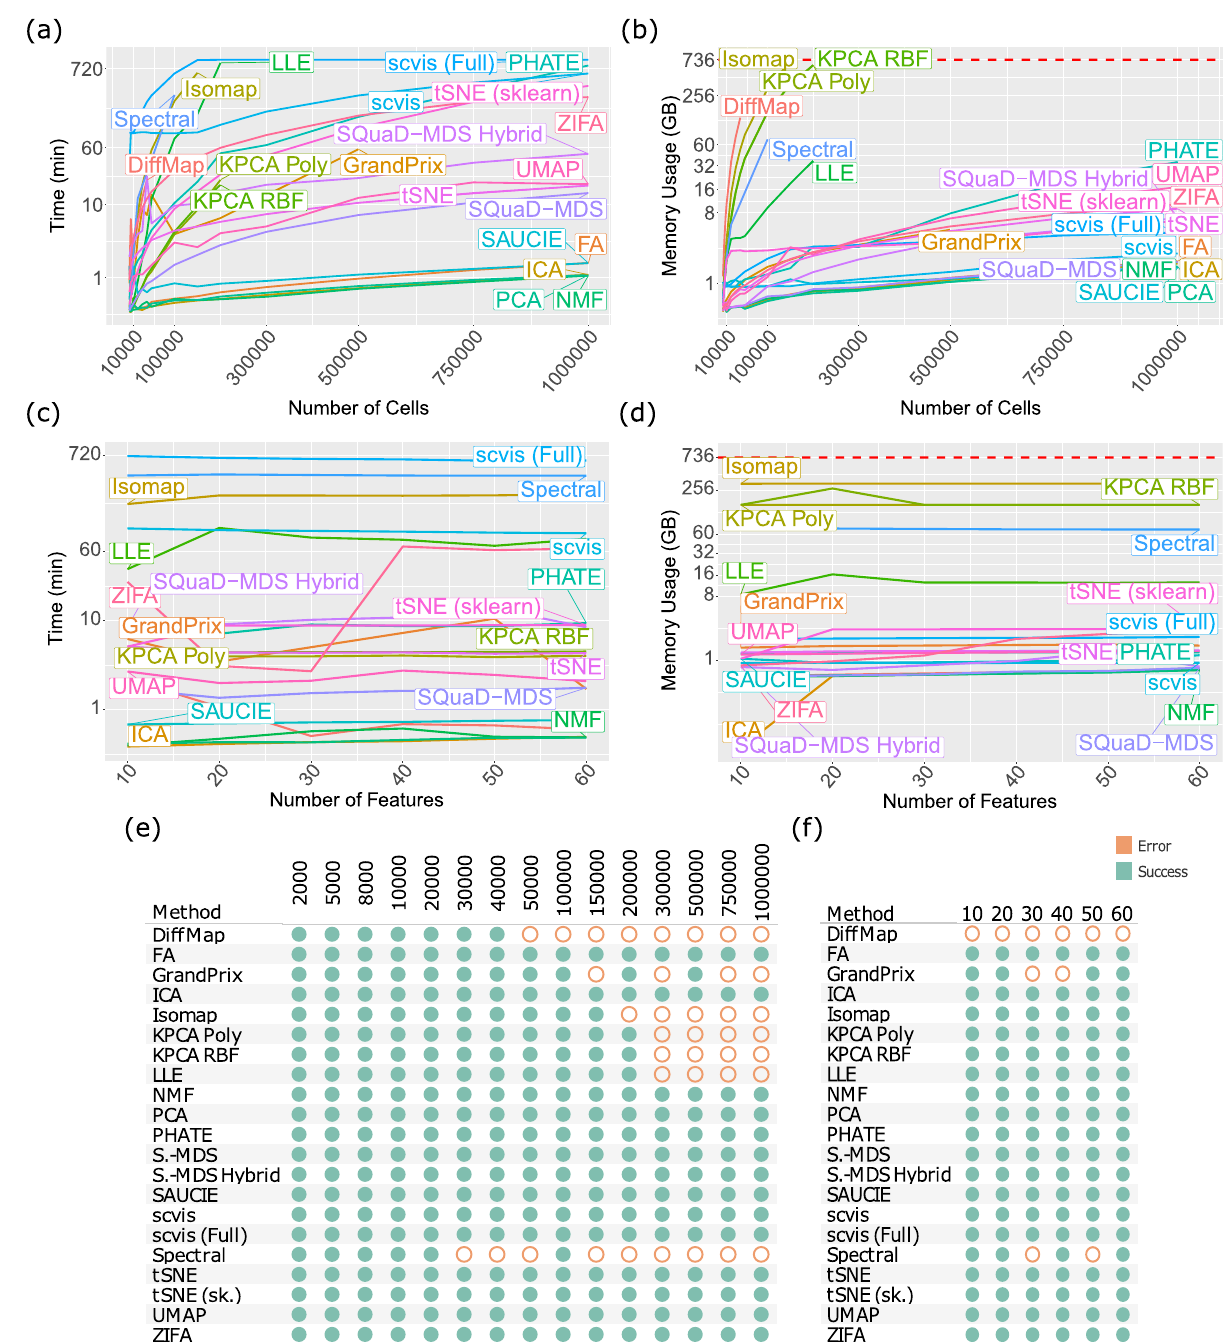
Fig.5|DetailedresultsonthescalabilityperformancesoftheDRmethods. The runtime( a , c )andmemoryusageconsumption( b , d )oftheDRmethods.In( a )and ( b ),theDRmethodswereevaluatedbasedonincreasingnumbersofcells.In( c )and ( d ), the DR methods were evaluated based on increasing numbers of protein